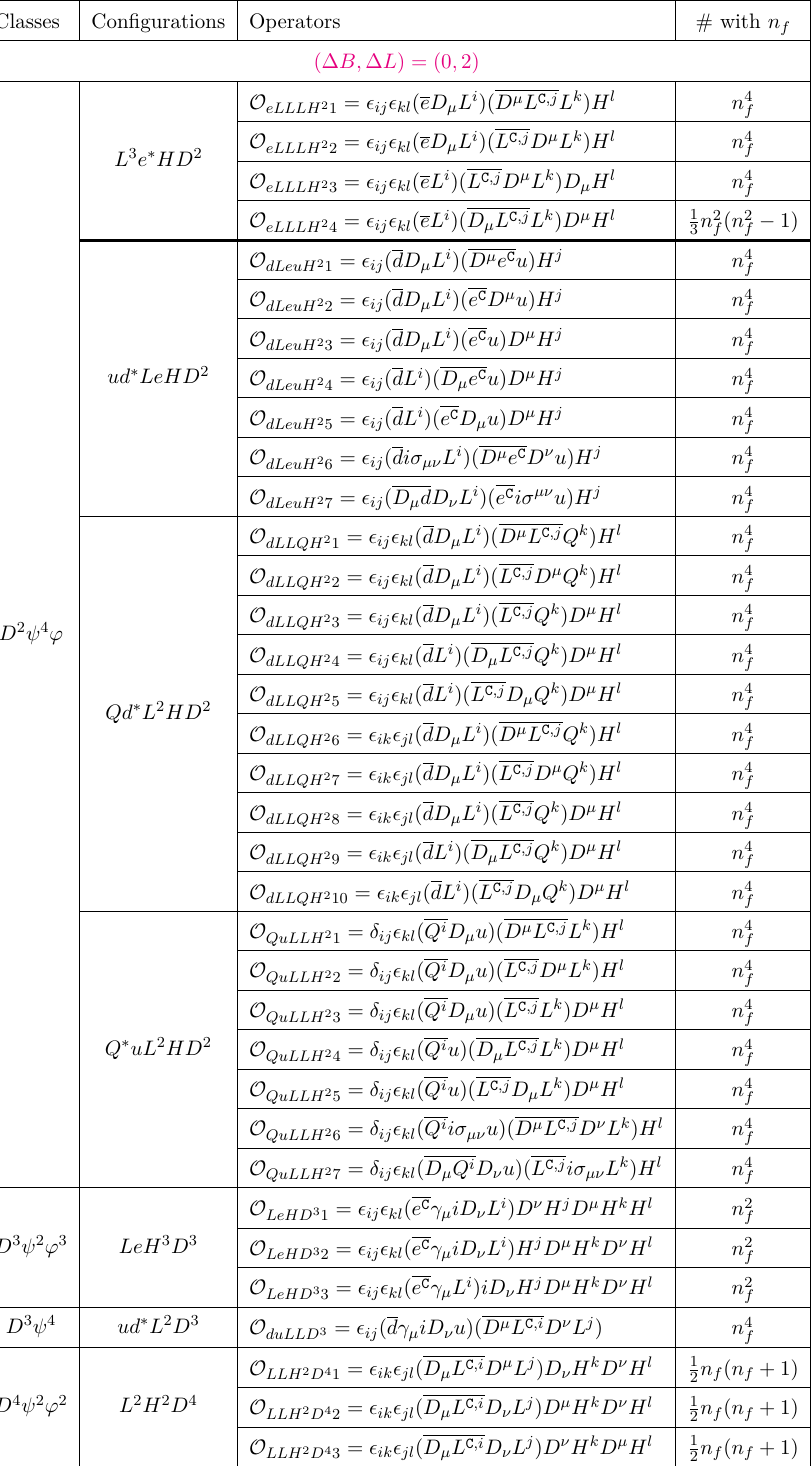
Table 6 . Dim-9 operators in classes D 2 ψ 4 ϕ, D 3 ψ 2 ϕ 3 , D 4 ψ 4 , D 4 ψ 2 ϕ 2 for sector (∆ B, ∆ L ) = (0 , 2) . There are 35 operators without counting fermion generations and 34 remain for one generation case. Hermitian conjugated operators are not included or